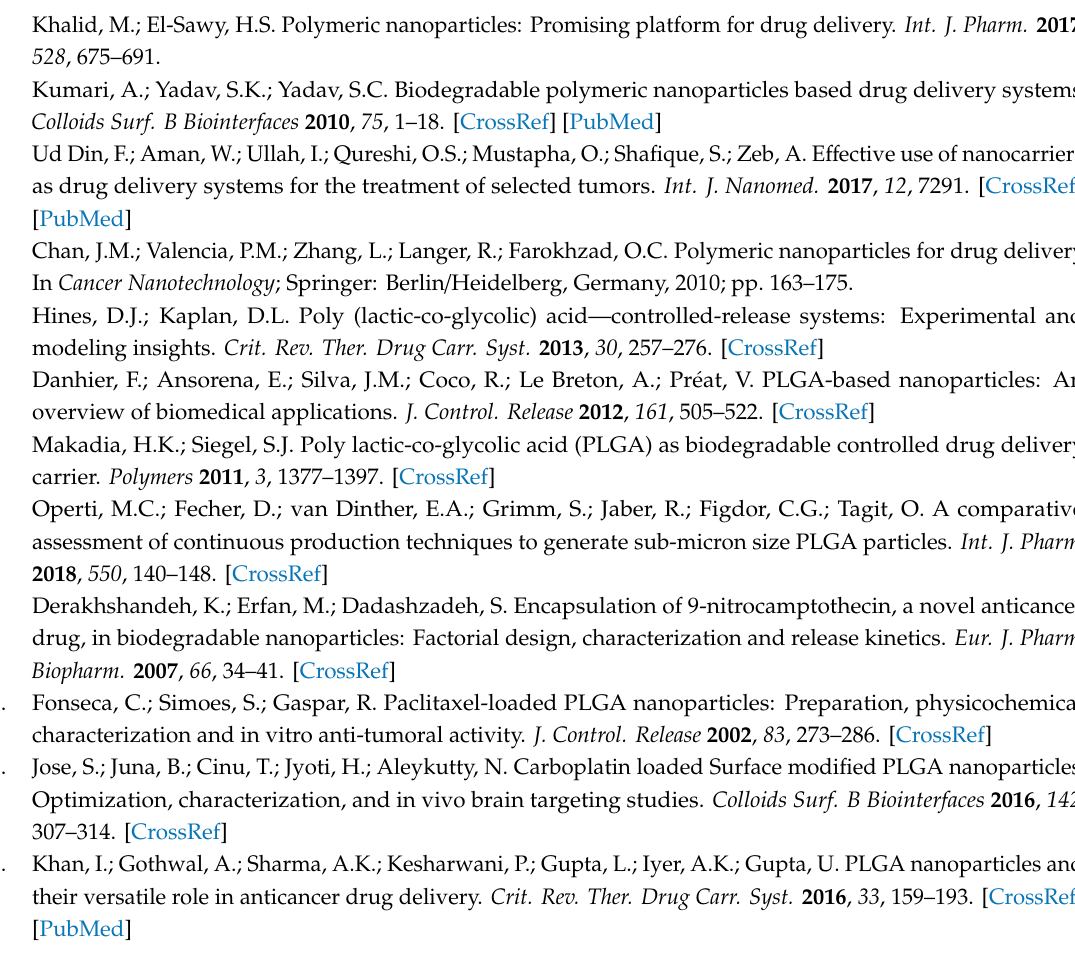
Figure S1: Flow cytometry histograms of the uptake experiments, Figure S2: Size distribution and ζ potential values of PLGA particles encapsulating a NIR-emitting fluorescent dye, Figure S3: Variations of spleen fluorescence intensities of ~100 nm and ~200 nm PLGA particles obtained on an isolated spleen at 24 h and 48 h after particle